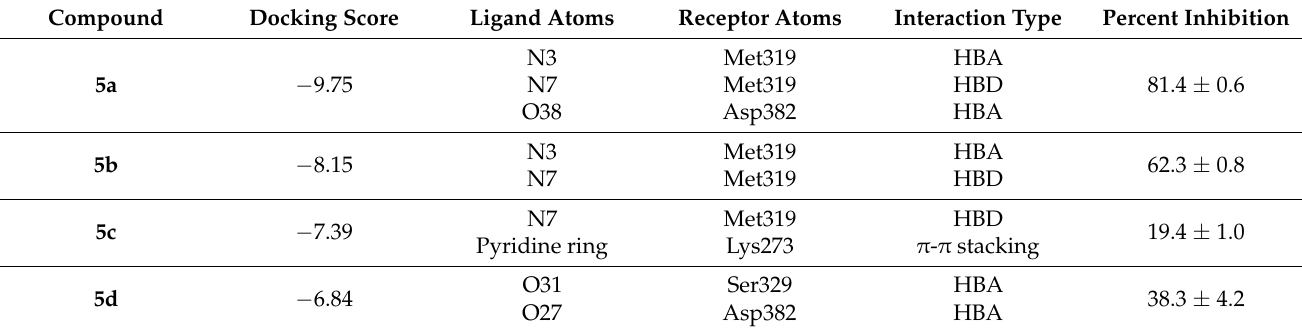
Table 5. Computational analysis of all synthesized compounds against